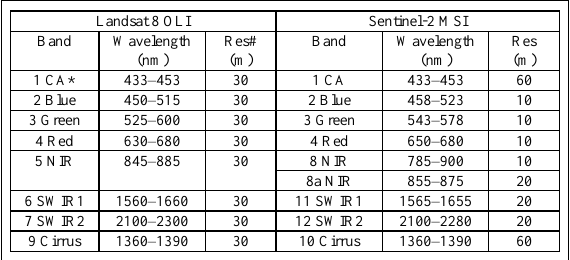
Table 1. Corresponding spectral channels and resolutions of OLI and MSI (*CA: coastal aerosol; #Res: Resolution) Comparison between MSI and OLI is to provide basis for joint use of different observations. As shown in Figure 1, differences in SRFs are significant over several channels (i.e., in VNIR region), while differences of SRFs for other channels are minor (Figure 1). Effect of the difference in SRF on corresponding values between MSI and OLI was investigated, including channel reflectance and derived spectral index. Investigations were mainly based on spectra simulation. Valid spectra samples from ASTER Spectral Library Version 2.0 and Hyperion